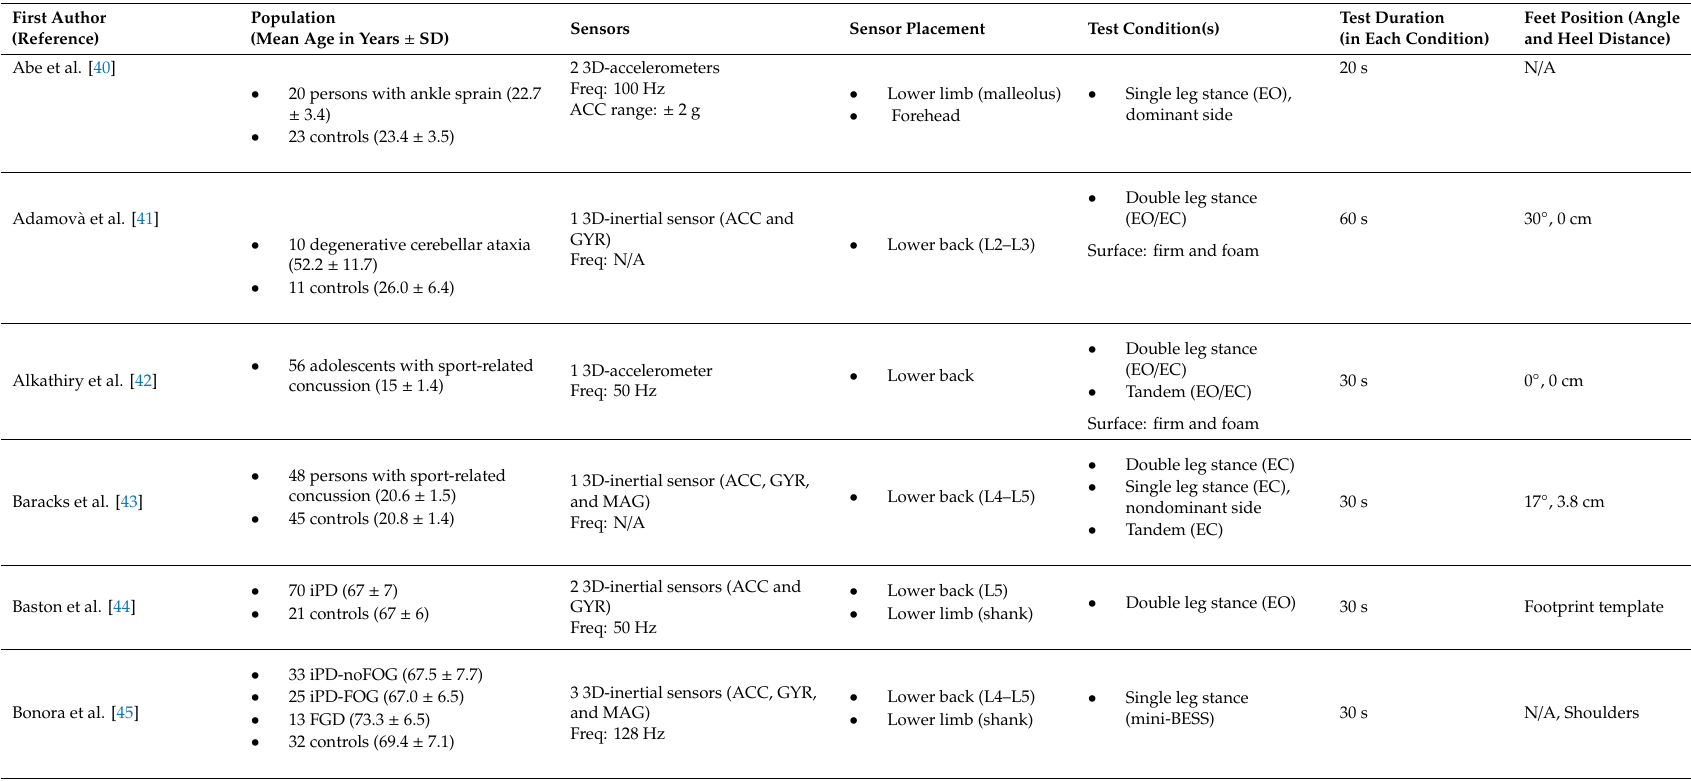
Table 3. Summary of the main characteristics of the articles included in the